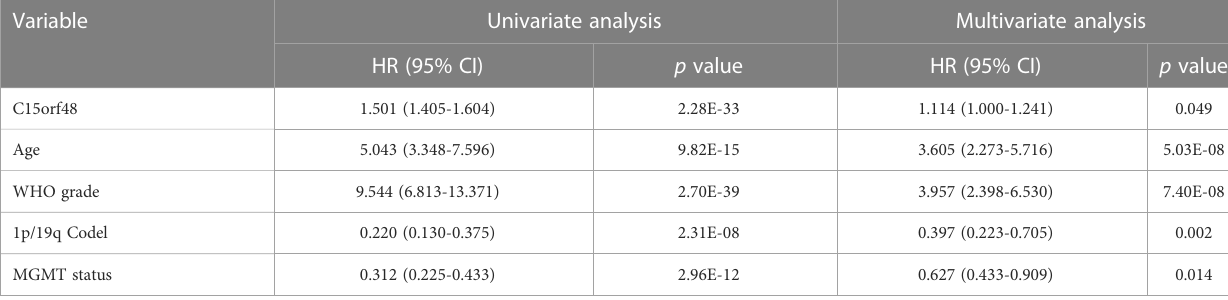
TABLE 1 Univariate and multivariate analyzes of OS prognostic parameters in the TCGA database. Variable Univariate analysis Multivariate analysis